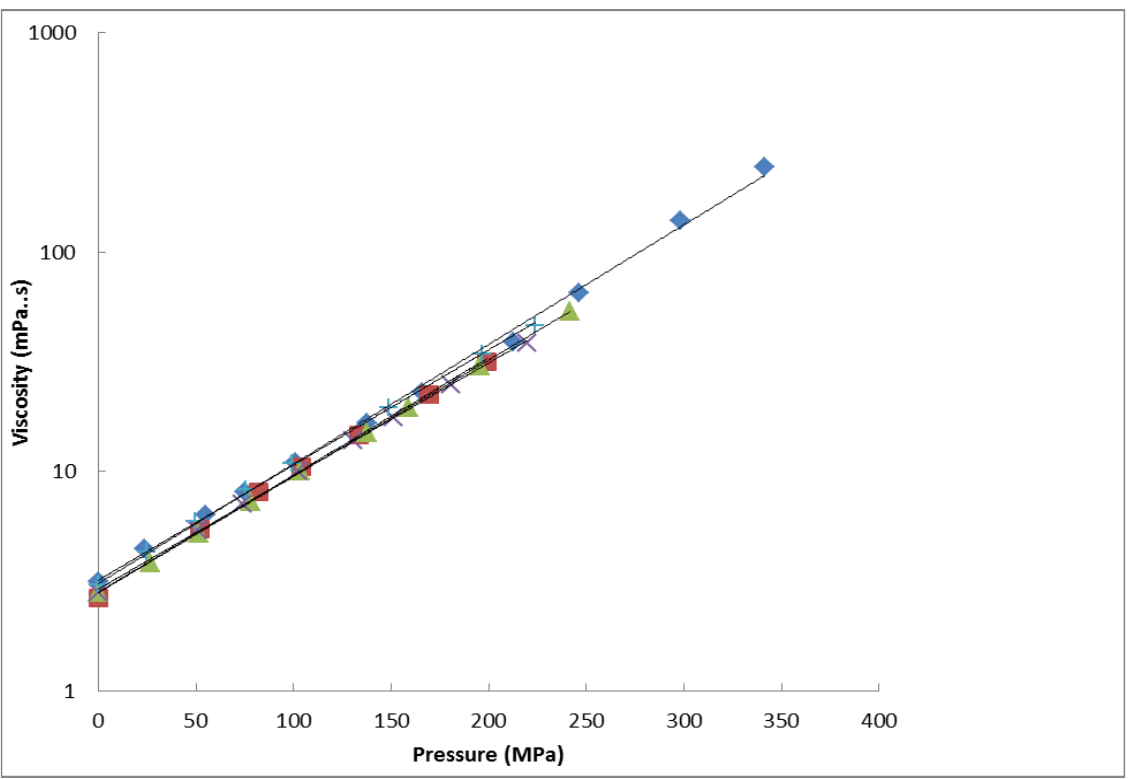
Figure 12. Comparison of the viscosities at high pressure at 298 K. + Fuel 1, ♦ Fuel 2, ■ Fuel 3, X Fuel 4, and ▲ Fuel